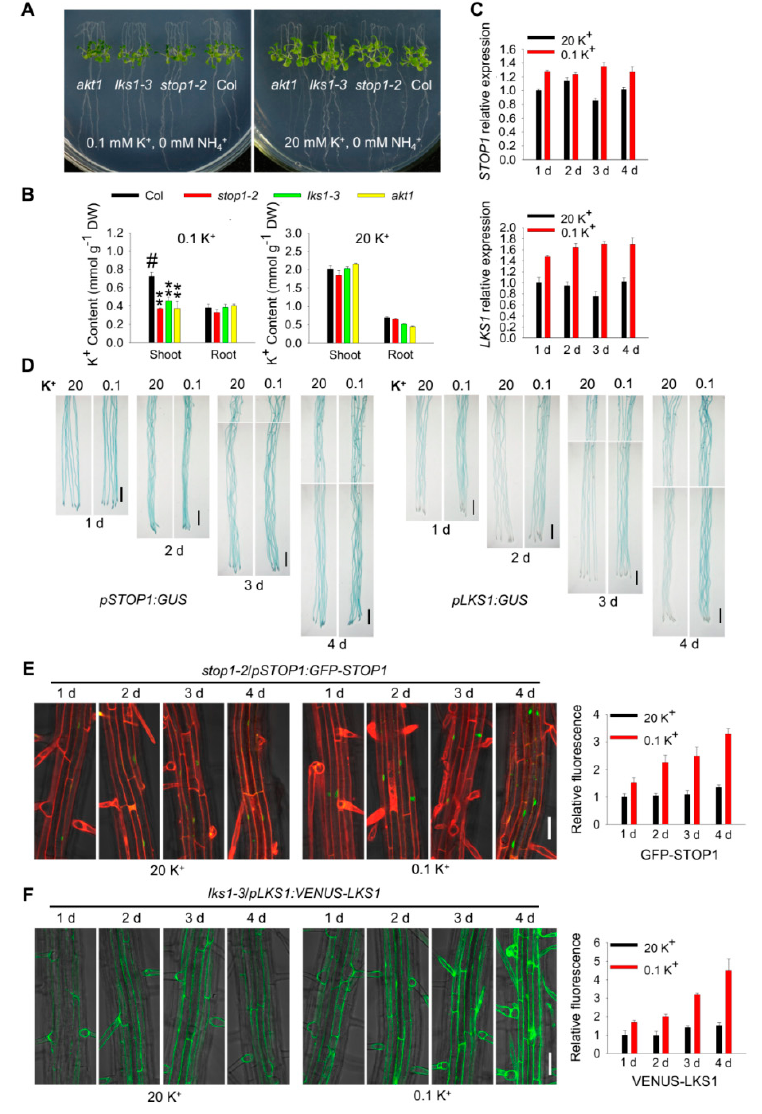
Figure 8. STOP1 and LKS1 are involved in low-K + response in the absence of NH 4 + . ( A ) Phenotype test of akt1 , stop1 , and lks1 mutants on high-K + (20 mM) and low-K + (0.1 mM) medium in the absence of NH 4+ . Seeds were germinated on high-K + (20 mM) medium for 5 days, and then the seedlings were transferred to high- or low-K + medium for 10 days. ( B ) K + content measurement of indicated plants shown in ( A ) after being transferred to high- or low-K + medium for 7 days. Data are shown as means ± SE ( n = 4). Student’s t -test (** p < 0.01) was used to analyze statistical significance; # represents the control. ( C ) RT-qPCR analyses of STOP1 and LKS1 expression in low-K + response in the absence of NH 4 + . The 5 day old seedlings were transferred to high- or low-K + medium for the indicated times. Then, roots were collected and used for RT-qPCR assays. Data are shown as means ± SE ( n = 4). ( D ) GUS staining showing STOP1 and LKS1 expression in low-K + response in the ab- sence of NH 4+ . The 5 day old seedlings were transferred to high- or low-K + medium for the indicated times, and then used for GUS staining. Scale bars = 2 mm. ( E , F ) Fluorescence observation showing the protein expression of GFP-STOP1 and VENUS-LKS1 after low-K + stress in the absence of NH 4+ . The relative fluorescence intensity of GFP-STOP1 ( n = 10) and VENUS-LKS1 ( n = 3) was calculated. The red fluorescence was due to the propidium iodine staining. The 5 day old seedlings were trans- ferred to high- or low-K + medium for the indicated times, and then used for fluorescence observa- tion. Scale bars = 50 μ m. We also analyzed the roles of STOP1 and LKS1 in the high-NH 4 + response. Under high-NH 4 + conditions (5/10/20 mM K + , 30 mM NH 4 + ), akt1 and lks1 mutants did not show